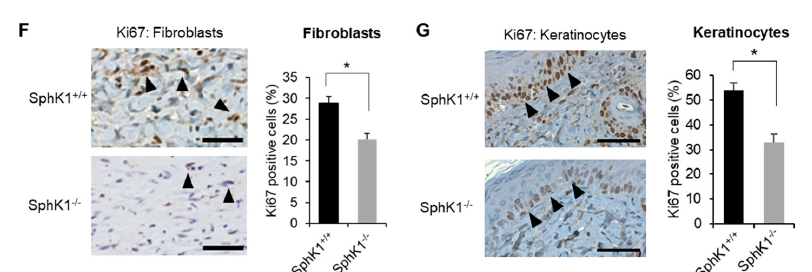
Figure 2. Effect of SphK1 knockout on wound healing, vasculogenesis, and cell proliferation. ( A ) Splinted excisional wounds were generated in SphK1 − / − and SphK1 +/+ mice. Representative images of the closing wounds are shown. ( B ) Change in wound area over time ( n = 6–10). ( C ) Representative images of CD34 expression on immunohistochemistry are shown. Arrowheads indicate positive findings (scale bars: 50 µm). ( D ) The numbers of CD34-positive microvessels per 200-fold magnified field are graphed ( n = 4). ( E ) The percentage of the wound area that is occupied by CD34 + cells is graphed ( n = 4). ( F ) Representative images of Ki67 expression in fibroblasts on immunohistochemistry are shown. Arrowheads indicate positive findings (scale bars: 50 µm). The frequencies of Ki67 + fibroblasts are graphed ( n = 4). ( G ) Representative images of Ki67 expression in keratinocytes on immunohistochemistry are shown. Arrowheads indicate positive findings (scale bars: 50 µm). The frequencies of Ki67 + keratinocytes are graphed ( n = 4). All values shown in this figure represent the mean ± s.e.m. * p < 0.05, ** p < 0.01.